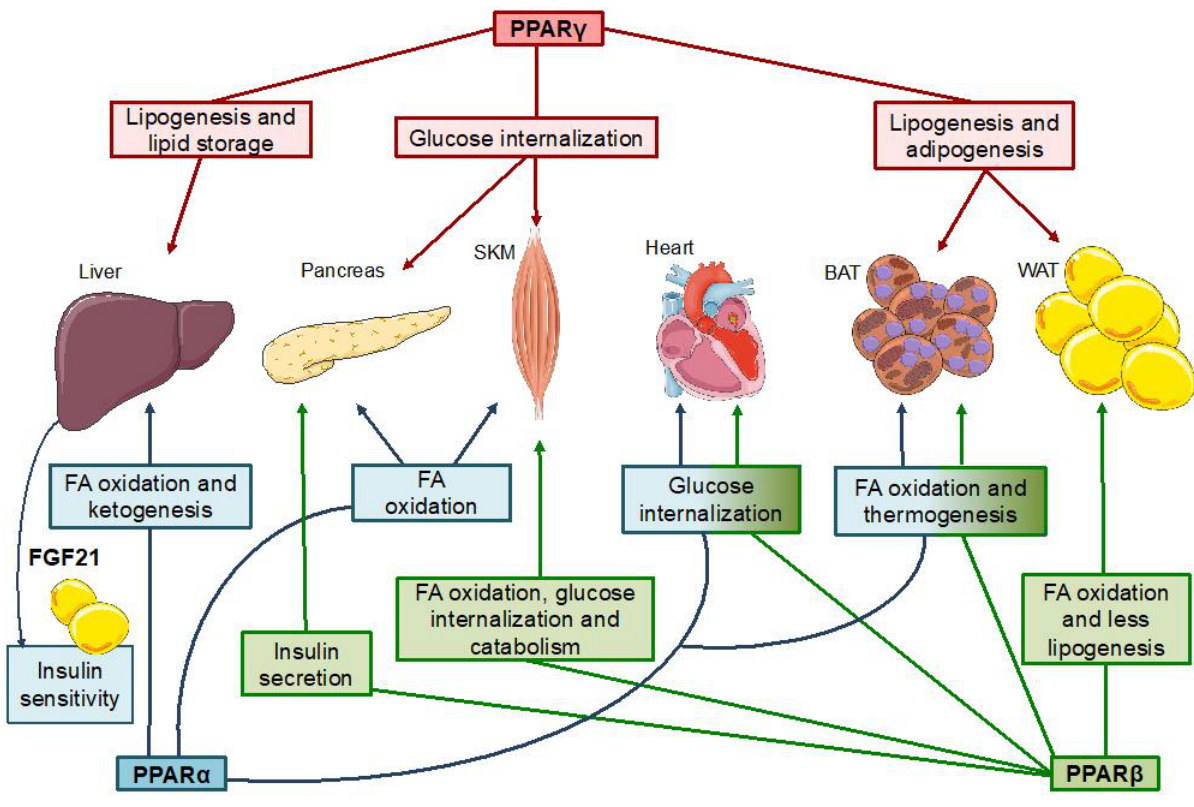
Figure 2. Metabolic functions of PPAR in the main organs and tissues. The three PPARs coordinate glucose and fatty acid (FA) homeostasis by acting on the liver, pancreas, skeletal muscle (SKM), heart, brown adipose tissue (BAT) and white adipose tissue (WAT), essentially. The actions of PPAR γ are shown in red, PPAR α in blue and PPAR β in green. This figure was created with Servier Medical Art (https://smart.servier.com/, accessed on 20 August 2020) under a creative commons license